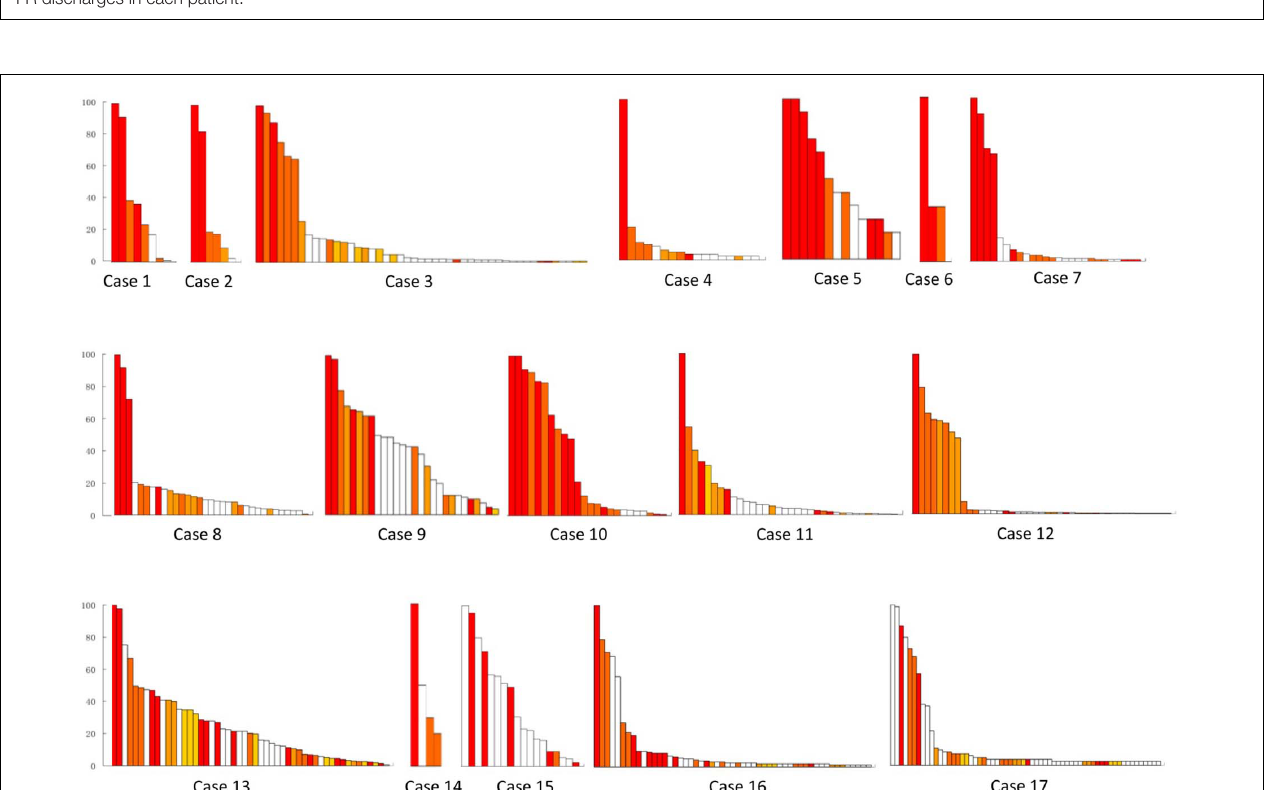
FIGURE 3 | Resective range of the tubers with FRs in all of the 17 patients. This figure shows the removed fast ripple tubers in each patient, and the number was 48 in total. White bars show the reserved tubers with FR discharges. Color bars show the removed tubers with FRs, and different color bars meant different removed tubers in each patient. Patients 13–17 suffered continuous seizure attack after resective operations. y -axis was the ratio of FRs on each tuber. x- axis was tubers in order of the ratio of FRs in different tubers in each patient.